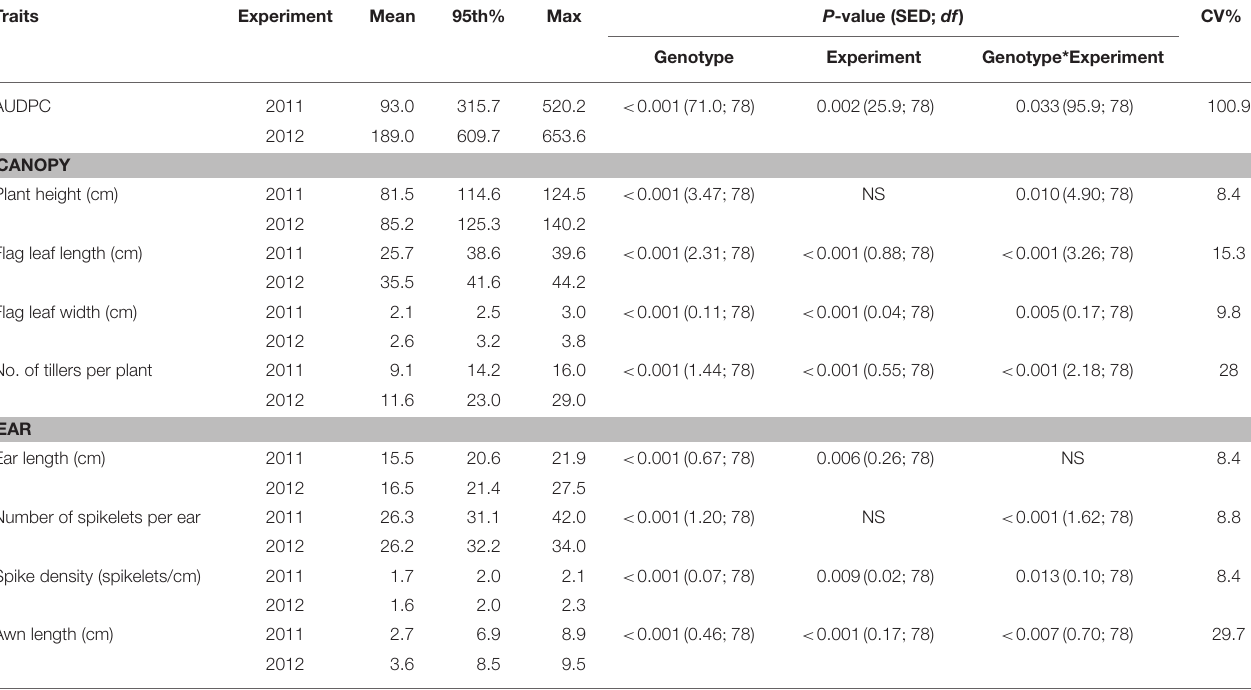
TABLE 2 | Area under the Disease Progress Curve (AUDPC), canopy and ear traits of wheat genotypes, described by the mean, 95th percentile and maximum values, assessed in glasshouse experiments in 2011 and 2012. Traits Experiment